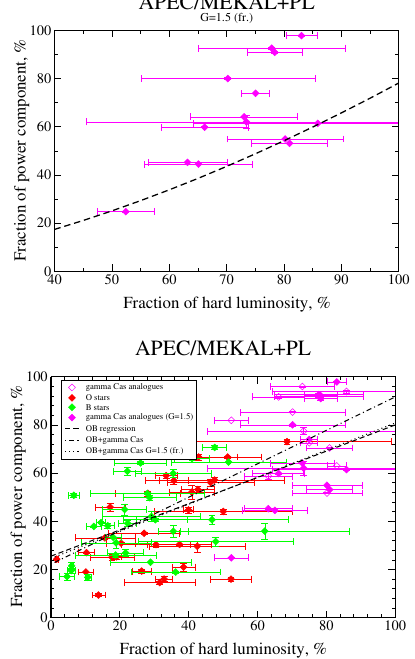
Figure 6. Dependence between the fraction of hard luminosity and hardness ratio for γ Cas analogues ( top panel ) and for typical OB stars together with them ( bottom panel ).